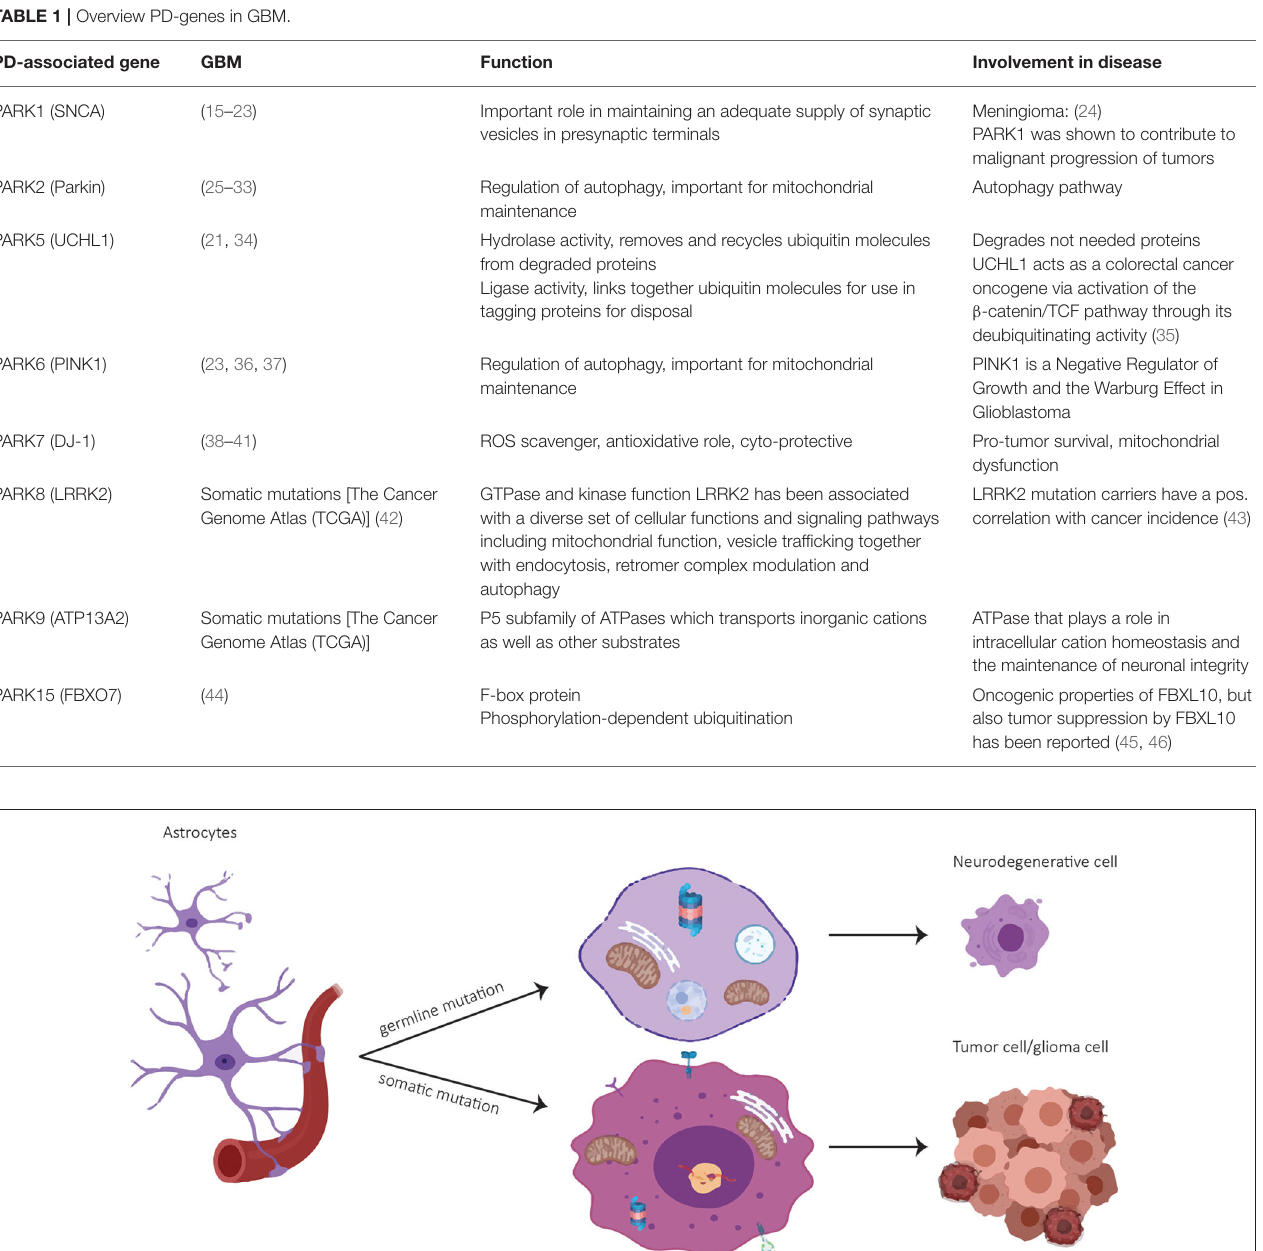
P53—The Master Controller of Cell Proliferation and Its Regulation in PD and